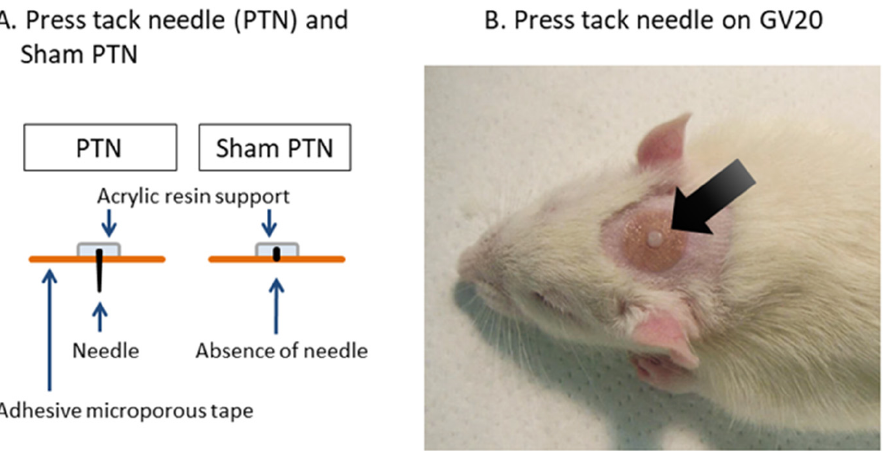
Figure 1. Press tack needle and acupuncture point GV20. ( A ) Schemas of PTN and sham PTN. ( B ) PTN was fixed on the acupuncture point that corresponds to human GV20 (Baihui, black arrow) acupuncture point. GV20, Governor Vessel 20; PTN, press tack needle.